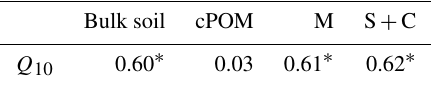
Table 3. Relationship between SOC temperature sensitivity ( Q 10 ) and C : N ratios of bulk soil and SOC